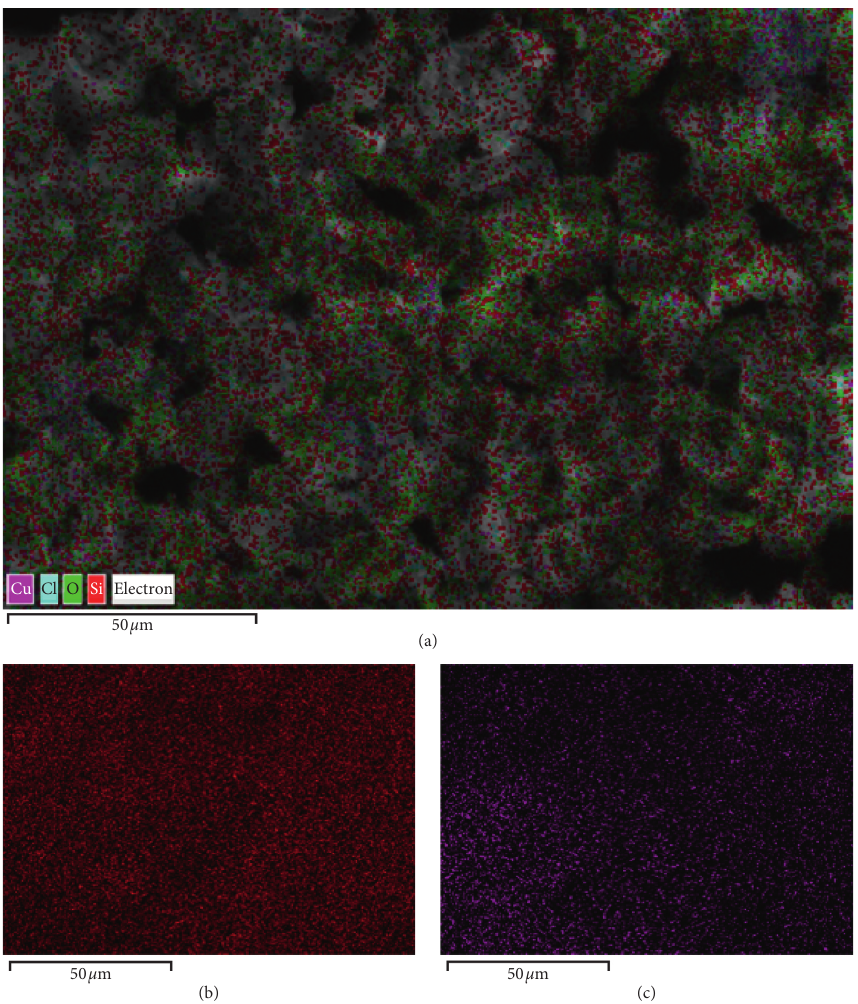
Figure 3: EDX elemental mapping images of 2CuCl/diatomite: (a) total elements, (b) Si element, and (c) Cu